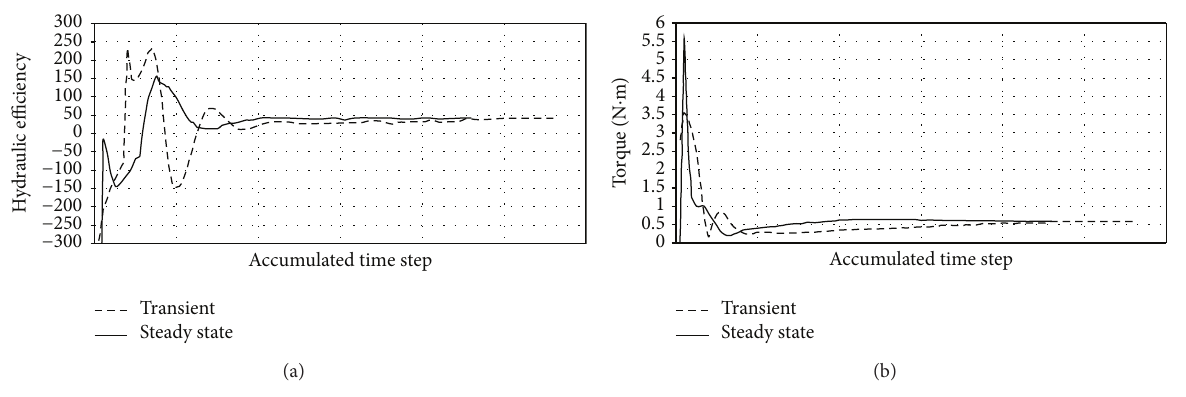
Figure 8: Variations in hydraulic efficiency of the pump and torque on impeller during accumulated time steps.